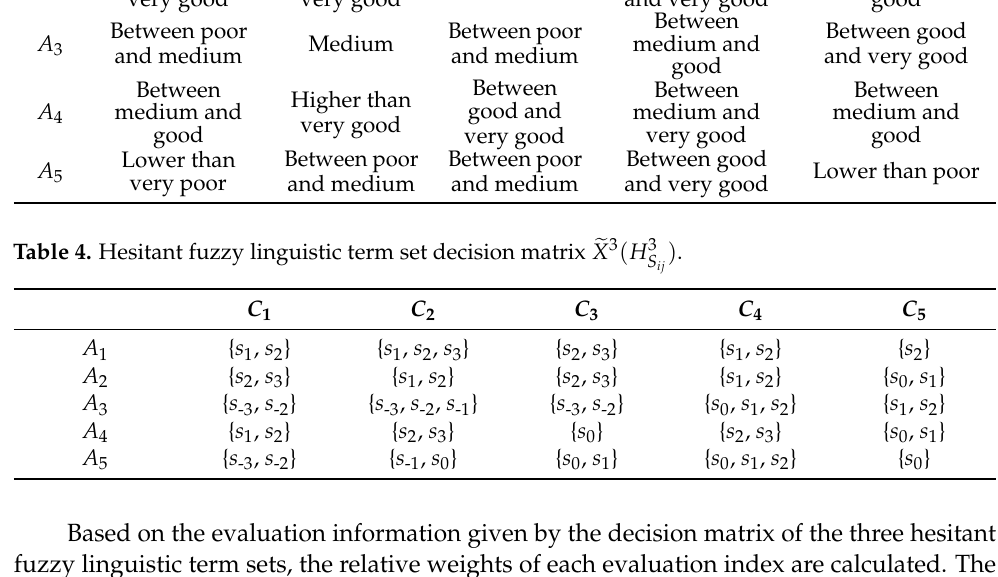
Between good Higher than good Between good and very good Between medium and good Lower than poor